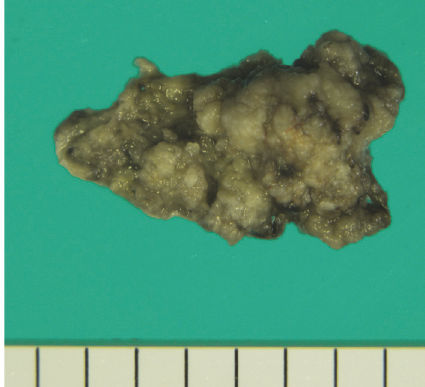
Figure 1: Surgical specimen showing the papillomatous, yellowish nodular lesion measuring 4 × 2cm.